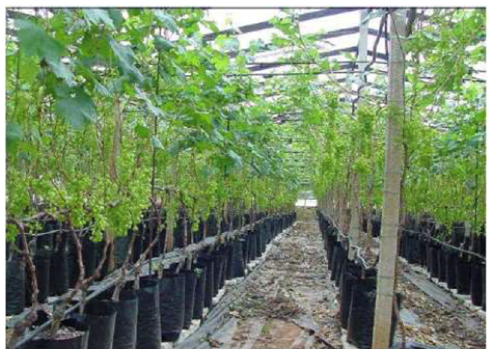
Figure 1. Table-grape soil-less cultivation in polyethylene containers under low-technology